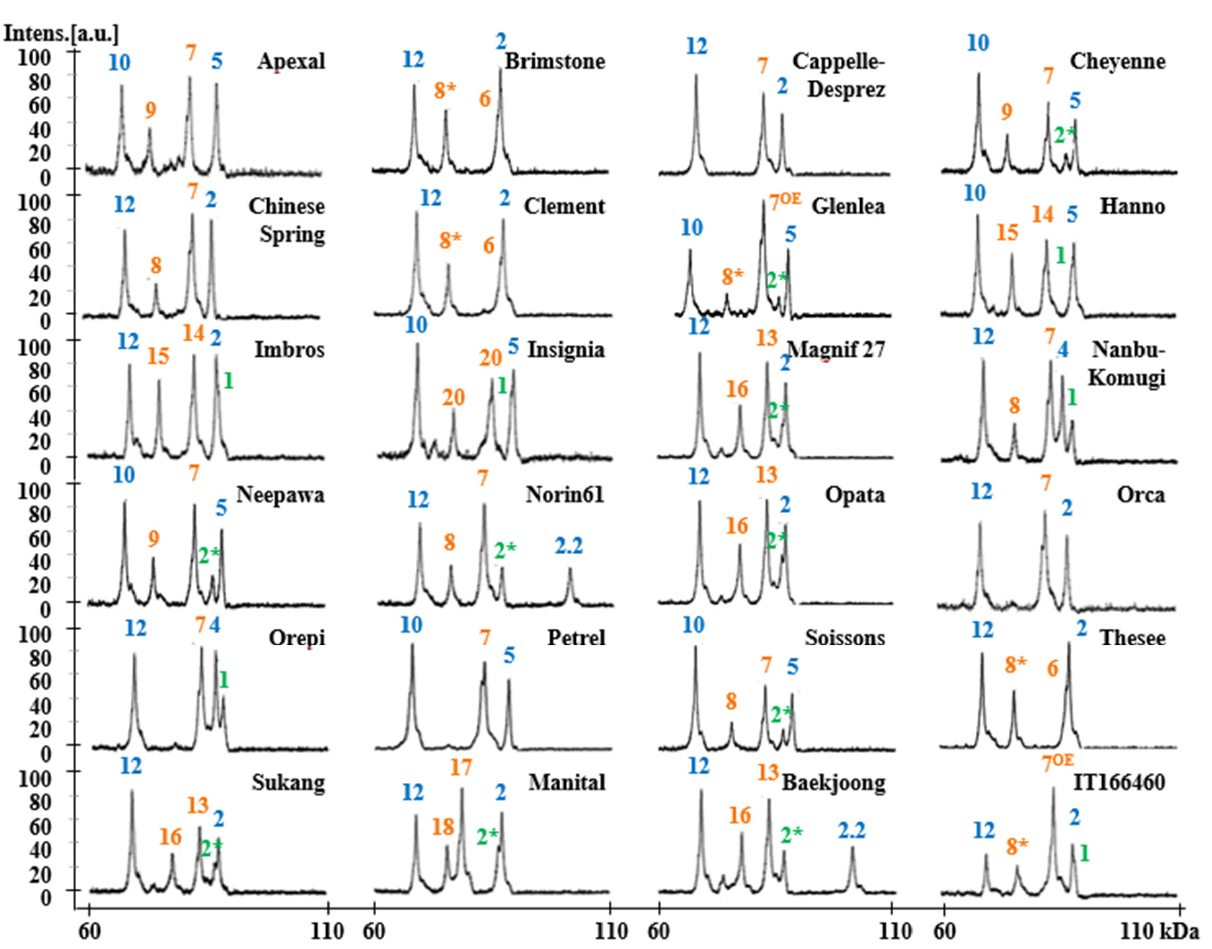
Figure 2. HMW-GS profiles of standard wheat cultivars determined by MALDI-TOF-MS. Subunits corresponding to chromosomes 1A, 1B, and 1D are displayed in green, orange, and blue, respectively. Molecular weights of HMW-GS determined by MALDI-TOF-MS were compared with those determined from mature protein sequences deduced from HMW-GS genes with the exception of 1By8* and 1Dx4 for which gene sequences were not available in public databases (Table 3). N-termini of proteins were as determined by Shewry et al. [52] and the molecular weight of 4-vp (105.14 Da for each cysteine residue) was deducted from molecular weights determined by MALDI-TOF-MS. Predicted and measured molecular weights di ff ered by less than 230 Da with errors less than − 0.30% for all HMW-GS except 1Bx7, 1Bx17, and 1Dx2.2. Considering the error rate of our mass spectrometer, this indicates that our optimized method for sample extraction and spectral analysis is reliable. In comparison, 32 of 94 HMW-GS measured by Gao et al. [20] differed by more than 230 Da from their predicted molecular weights. It is more difficult to compare the accuracy of measurements in the Liu et al. [50] study since the measured values were presented as an average for the protein type and rounded to the nearest hundred. Nonetheless, values obtained for Bx14, By15, and Dy12 differed by more than 352 from molecular weights predicted from gene sequences. As more HMW-GS gene sequences have become available, small differences in the sequences of genes from different cultivars have become apparent, resulting in minor changes in the molecular weights of the encoded proteins. Nonetheless, in the current study the same subunit generally displayed similar molecular masses in different genotypes. However, two distinct molecular weights with a difference of ~600 Da were detected in genotypes containing the 1Bx7 HMW-GS, 82,400 Da (group 1) and 83,000 Da (group 2) (Table 3). Interestingly, the molecular masses detected in genotypes containing 1Bx7 OE were also 83,000 Da. In previous studies, it was not possible to discriminate 1Bx7 and 1Bx7 OE by either mobility in SDS-PAGE or retention time in RP-HPLC [33]. A molecular weight difference of about 600 Da suggests that the group 2 proteins may contain an additional six amino acid residues. Butow et al. [10] revealed that compared to 1Bx7, 1Bx7 OE has an 18 bp insertion in the repetitive domain of its